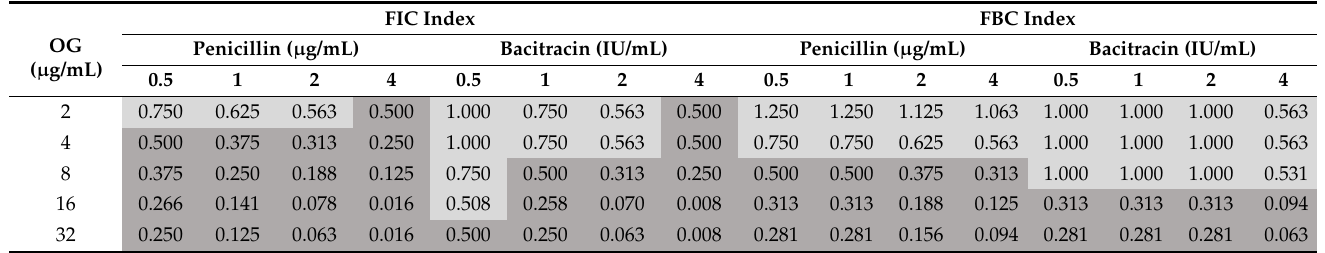
Figure 1. Synergistic bactericidal activity of octyl gallate (OG) in combination with penicillin ( A ) and bacitracin ( B ). White spots show bacterial growth, and empty space indicates growth inhibition. Table 2. The FIC and FBC indices of combinations of octyl gallate (OG) with penicillin and bacitracin in Staphylococcus epidermidis